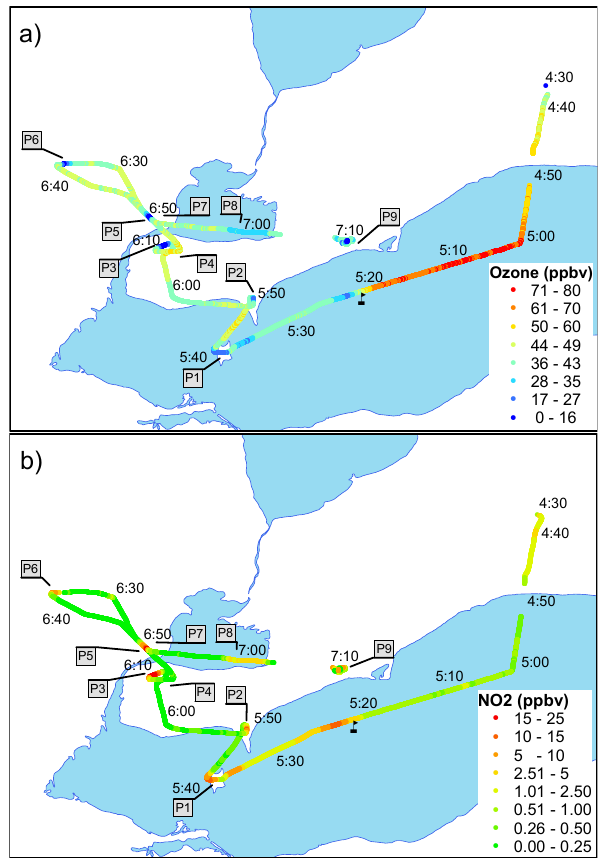
Fig. 7. Ozone (a) and NO 2 (b) measured at early morning hours (04:30–07:20EDT) of 7 July by the Twin Otter aircraft.